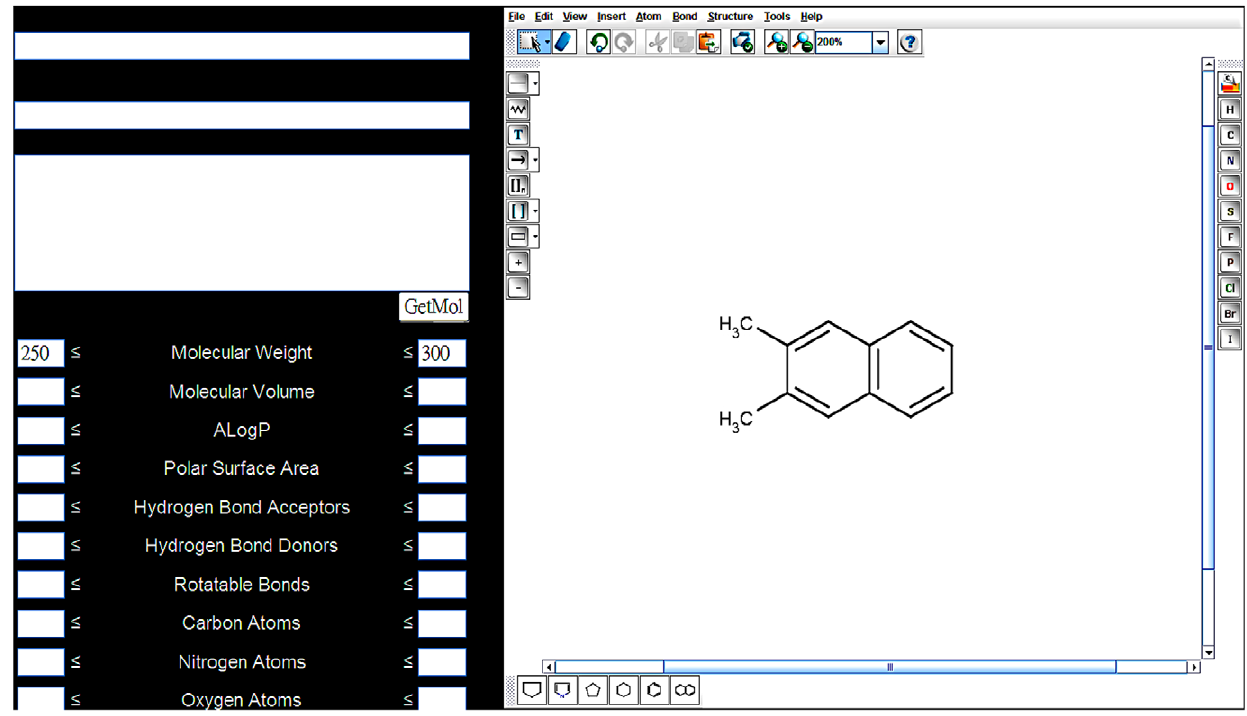
Figure 3. The advance search interface.